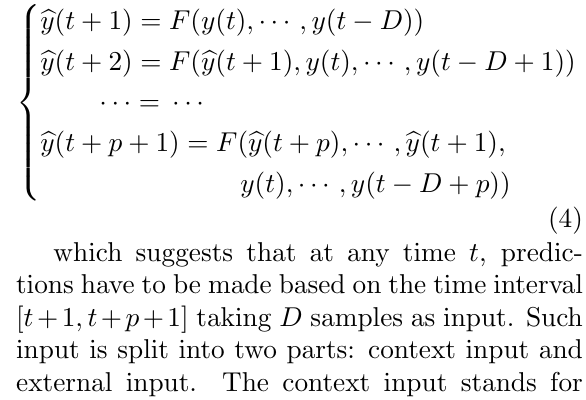
Fig. 1. Recurrent radial basis function with multi- step